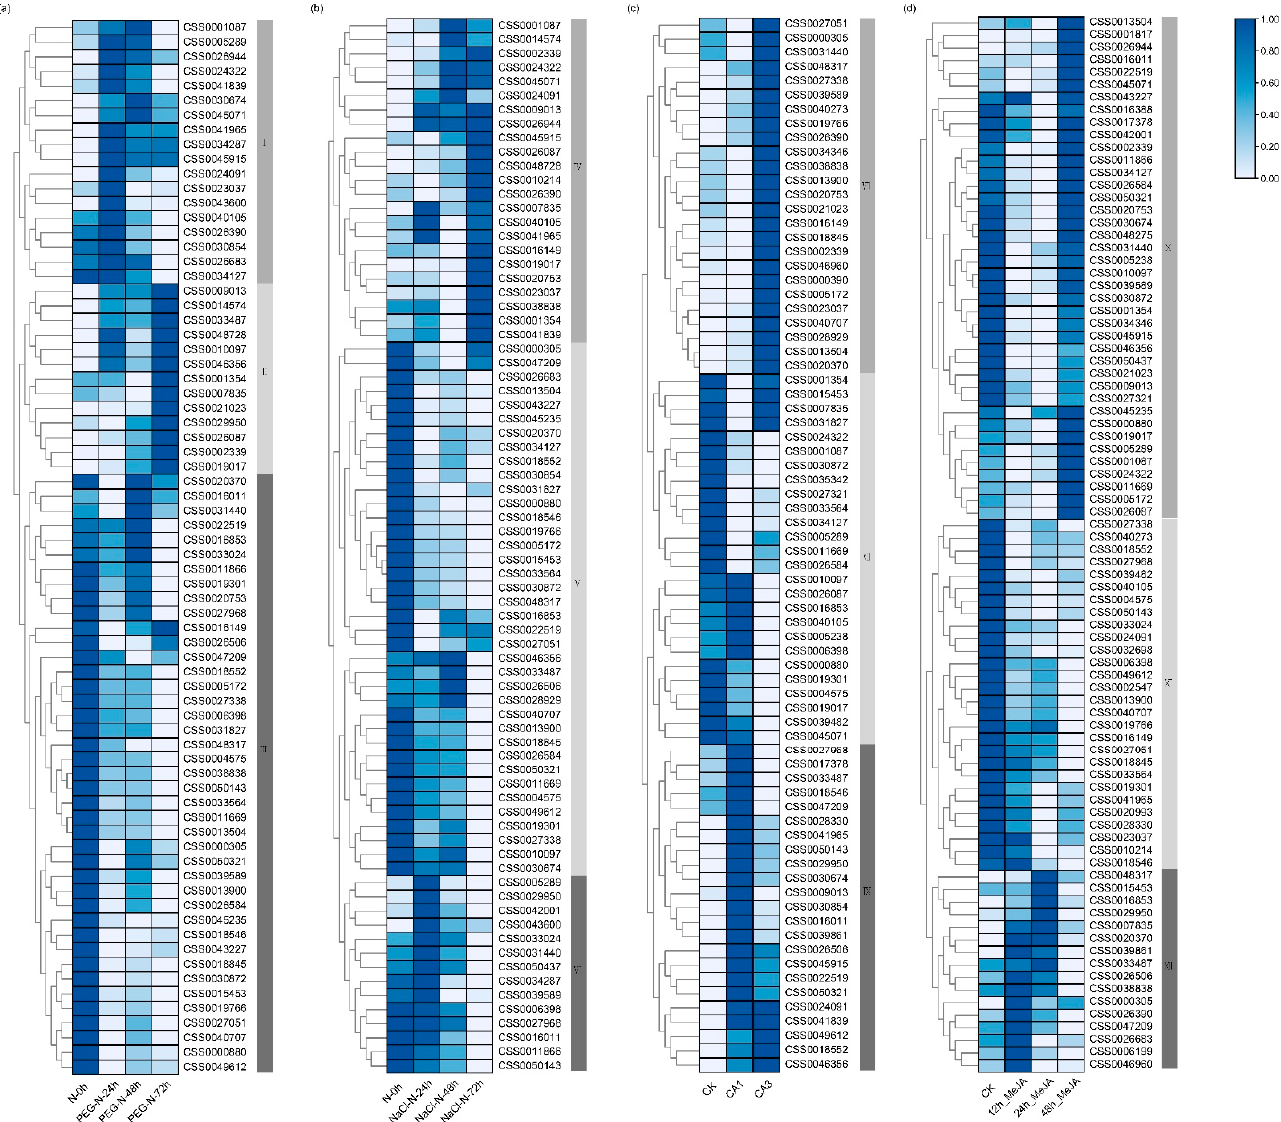
Figure 5. Expression patterns of CsC2H2-ZFP genes with different stresses. ( a ) Drought stress; ( b ) salt stress; ( c ) cold stress; ( d ) methyl jasmonate (MeJA) treatment. Control is placed at the leftmost column of heatmap. PEG, polyethylene glycol; CA1, fully acclimated; CA3, de-acclimated. The heatmap was visualized using log transformed values by TBtools software. The expression data from TIPA genome database was used to generate the heatmap by TBtools. The dark blue and light blue indicate high and low levels of gene expression, respectively.